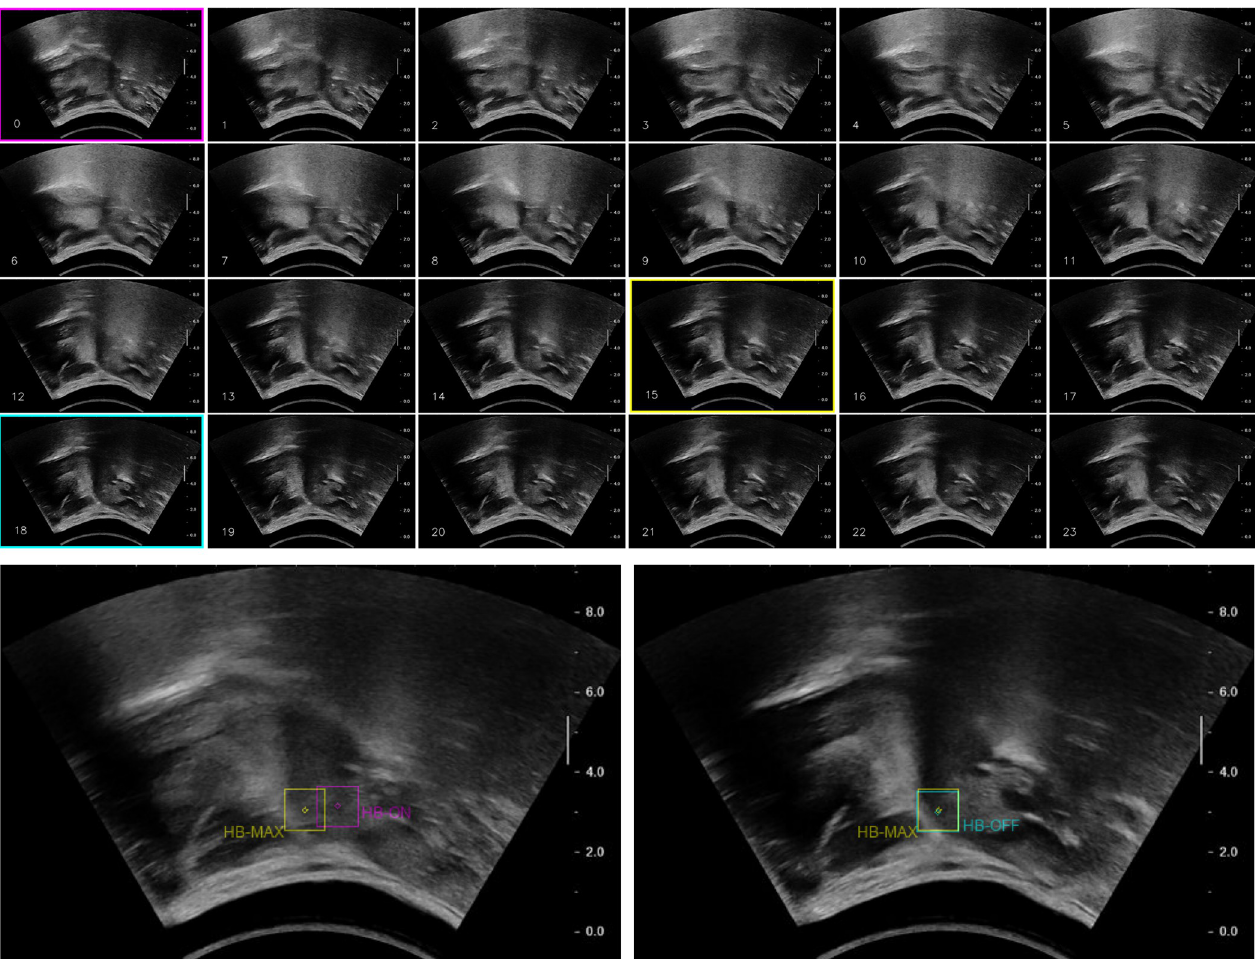
Fig 3. (a) Numbered sequential juxtaposition of sample hyoid bone excursion frames (from left to right, top to bottom); (b) corresponding superimpositions of HBOn/HBMax (left) and HBMax / HBOff (right). Note : Magenta frame = HBOn , Yellow frame = HBMax , Cyan frame = HBOff .